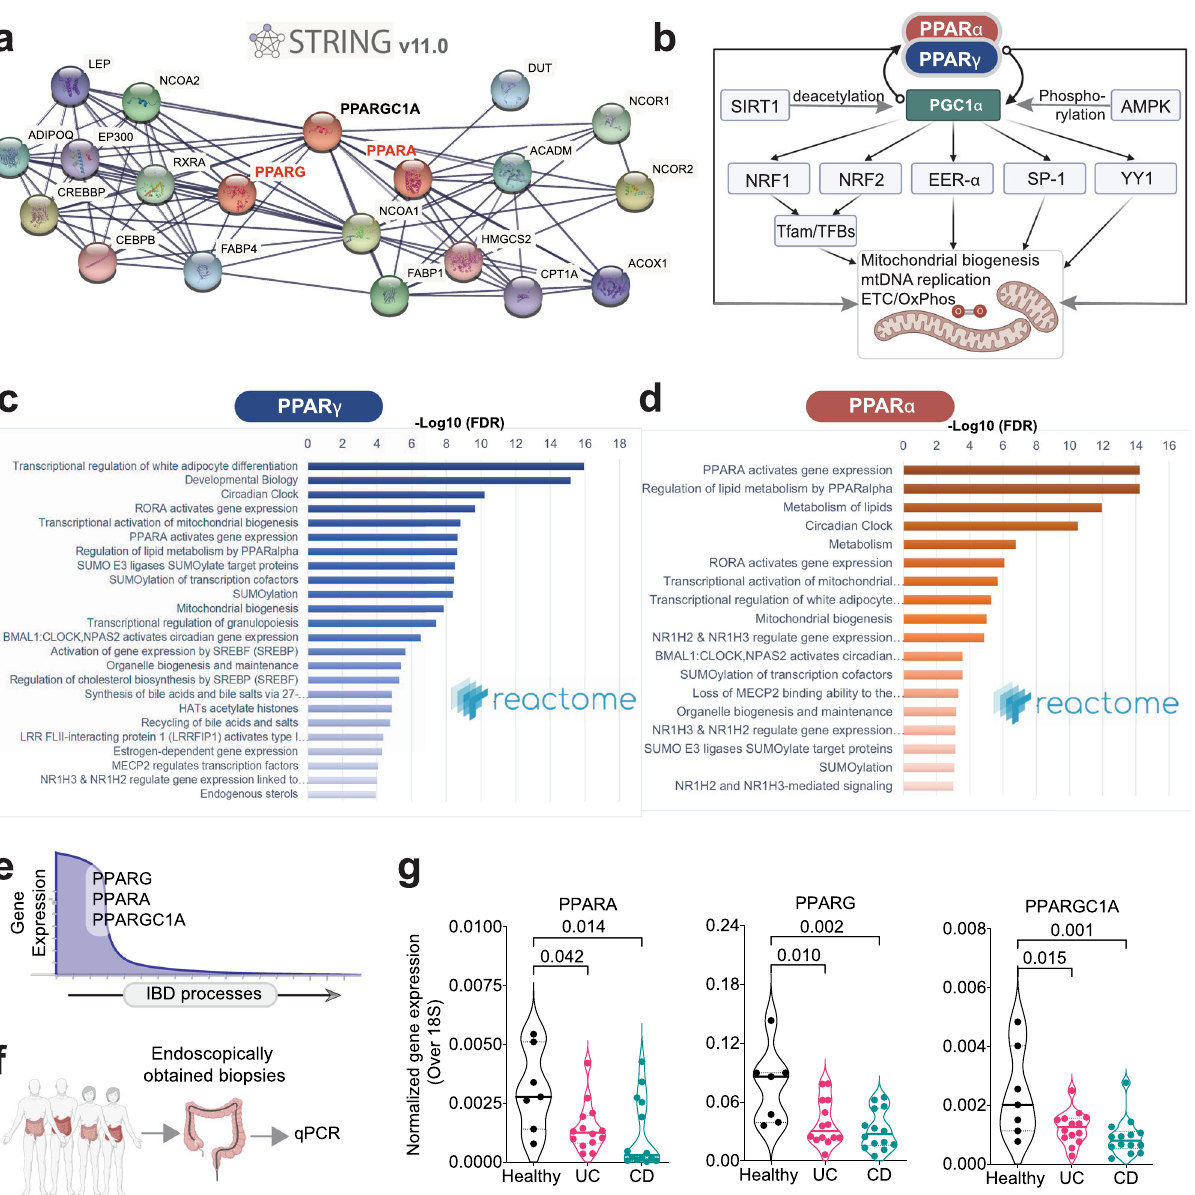
Fig. 3 Rationalization of PPAR α and PPAR γ as targets in IBD. a A protein – protein interaction network (i.e., interactomes) for PPAR α and PPAR γ , generated using STRING v.11 (https://string-db.org). b Schematic summarizing the roles of PPAR α , PPAR γ , and PGC1 α on mitochondria biogenesis and function (based on). PGC1- α emerges as a critical hub for forward feedback loops. c Reactome pathway analyses (www.reactome.org) on PPAR α and PPAR γ interactomes in a show convergence on metabolism, mitochondria bioenergetics, and the circadian clock. d Graphical visualization of the predicted changes in the expression of three genes (and the proteins they encode): PPARA (PPAR α ), PPARG (PPAR γ ), and PPARGC1A (PGC1- α ) during the progression of IBD processes (indicated with an arrow). e , f Schematic showing validation work fl ow; the expression of PPARA, PPARG, and PPARGC1A transcript levels were assessed in the ileum/colon biopsies of IBD patients (UC = 14 and CD = 14)) or healthy controls ( n = 7). g Violin plots display the qPCR results in ( e , f ). Results are displayed as mean ± SEM. Signi fi cance was tested using one-way ANOVA followed by Tukey ’ s test for multiple comparisons. Signi fi cance: n.s, not signi fi cant, p -value < 0.05 was considered signi fi